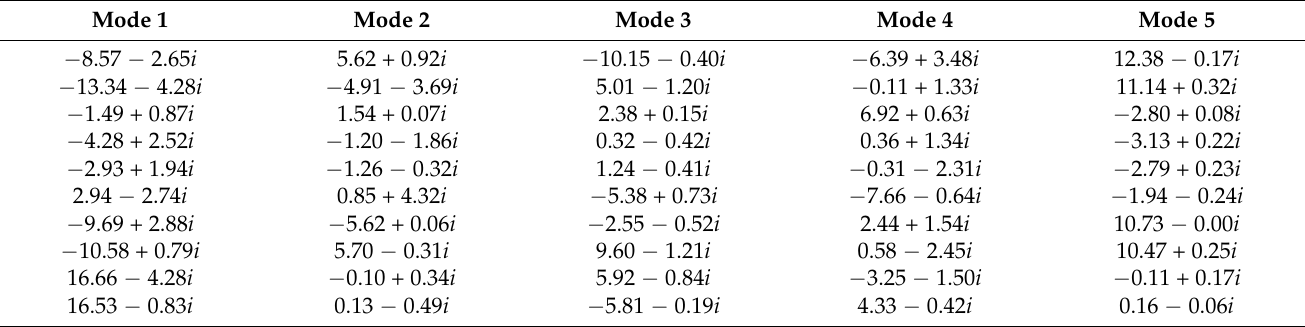
Table A2. Mode shape vector of UCBC #1 specimen. ( i : imaginary unit).